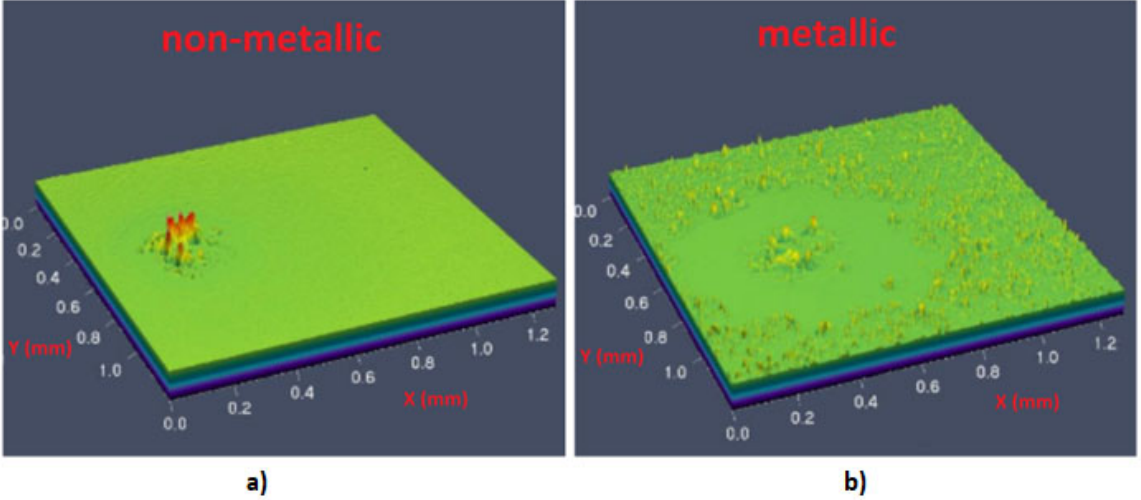
Figure 11. A general comparation of confocal microscopy for non-metallic for ( a ) and metallic sample for ( b ).